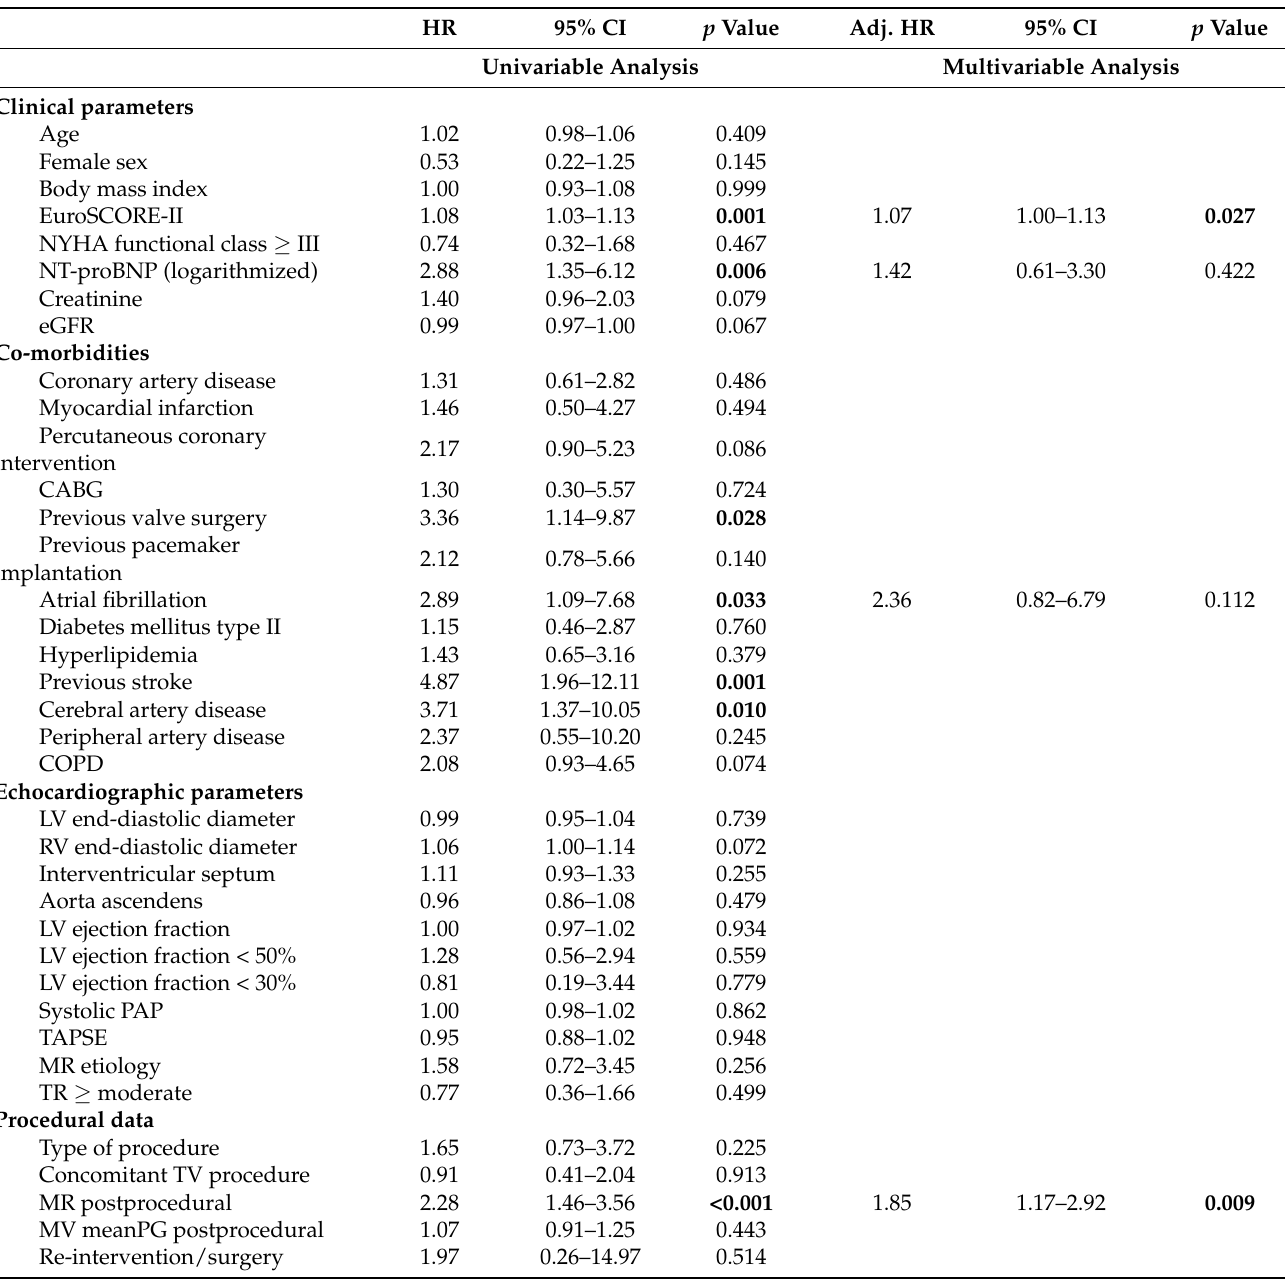
Table 3. Cox-regression analyses regarding associations with the primary composite endpoint (heart failure hospitalization/death) in the matched study population ( n = 102). Multivariable analysis was adjusted for all parameters with a significant influence at an univariable level (EuroSCORE-II, NT-proBNP, atrial fibrillation, MR postprocedural), excluding those already incorporated in the